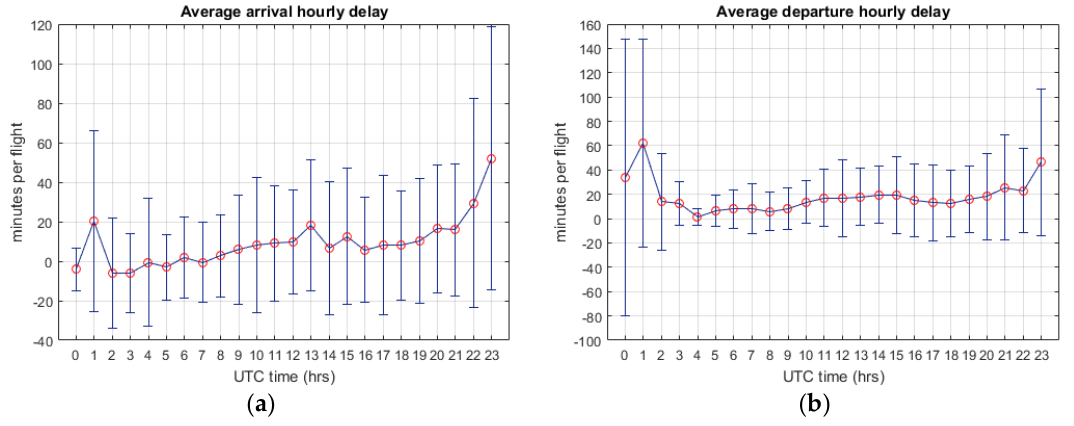
Figure 18. Evolution of average hourly ( a ) arrival delay (min/operation), and ( b ) departure delay (min/operation) throughout the day (the error bars denote one standard deviation intervals).